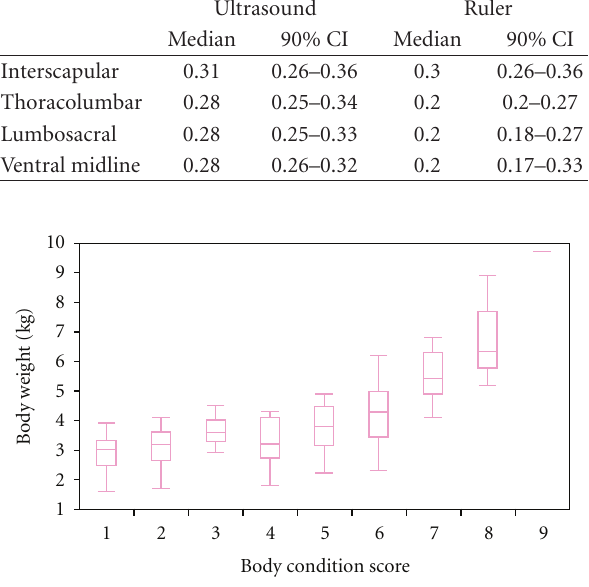
Figure 2: Distributions of raccoon body weight for each body condition score category (BCS 1–9), displaying median, quartiles, minimum, and maximum